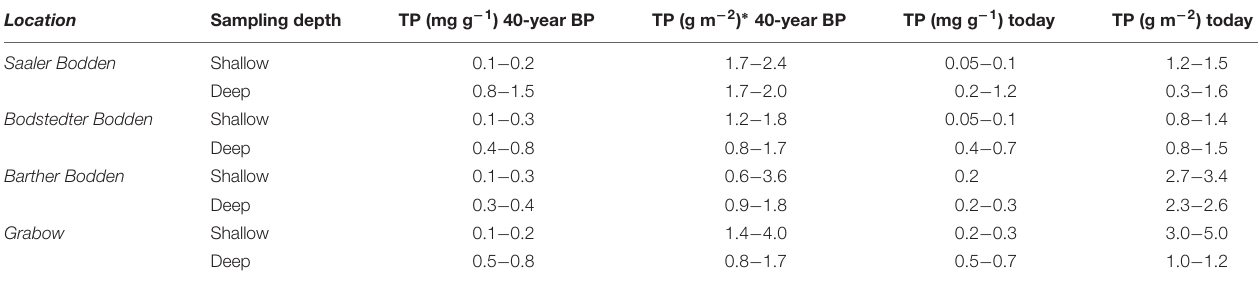
TABLE 3 | Total phosphorus (TP) (stock in g P m − 2 0–1 cm, and concentration in mg P g dry mass − 1 ) from 40 years ago (40-year BP – before present) compared with today at the same sampling spots.